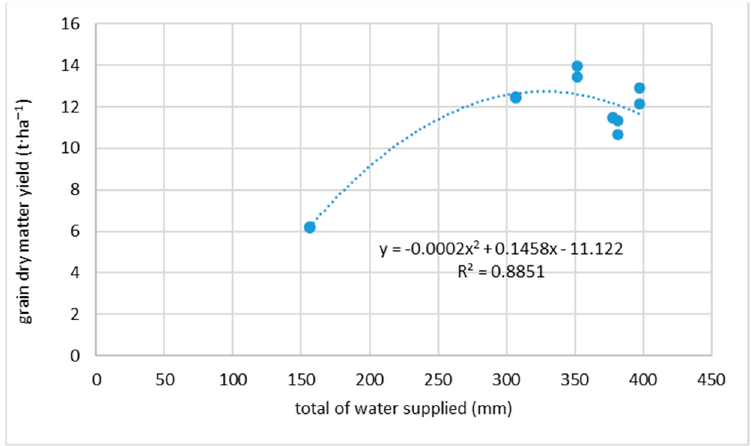
Figure 5. Dependence of dry matter yields of maize grain on water availability conditions during the period of active vegetation (June–Sept. 2015–2017).